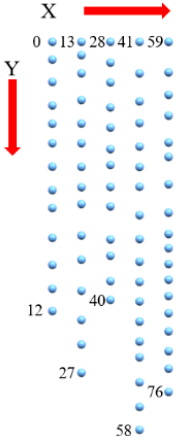
Figure 11. The schematized flow of the triangulation algorithm of 3D point-cloud. ( a ) Concatenate each point-cloud profile with lines; ( b ) Constructe the quadrilaterals; ( c ) Form the triangle-meshes;( d ) Finish the triangulation of the adjacent point-cloud profiles; ( e ) Complete the triangulation algorithm for the PCM. Thus, the triangulation of scratch-data PCM can be done by separately triangulating the reference PCM (Figure 12b) and the scratch-surface PCM (Figure 12c) using the algorithm described